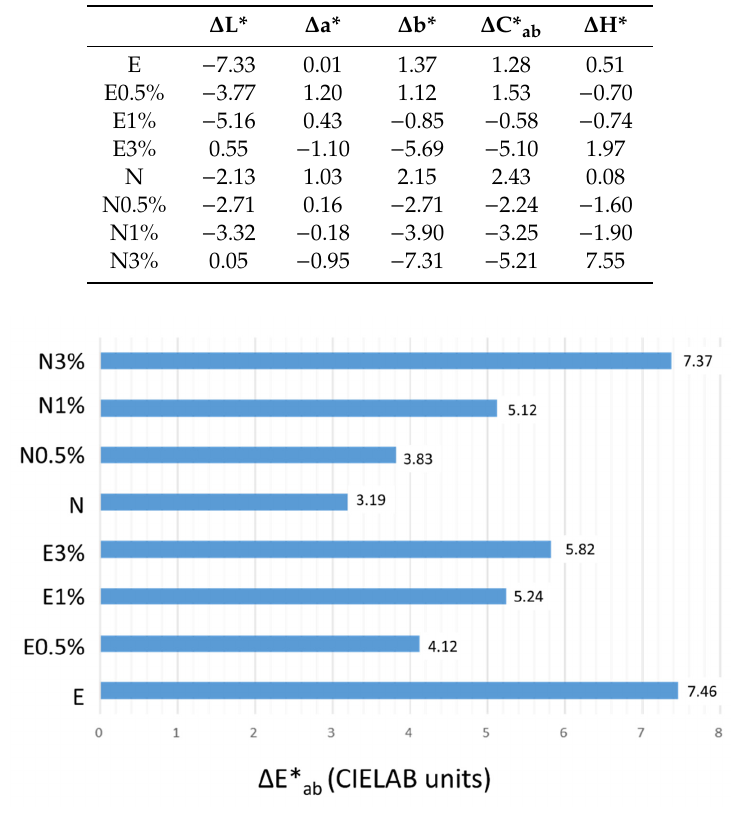
Figure 5. Global color change ( ∆ E* ab ) of the treated surfaces considering the color of the surface before to be treated as the reference.